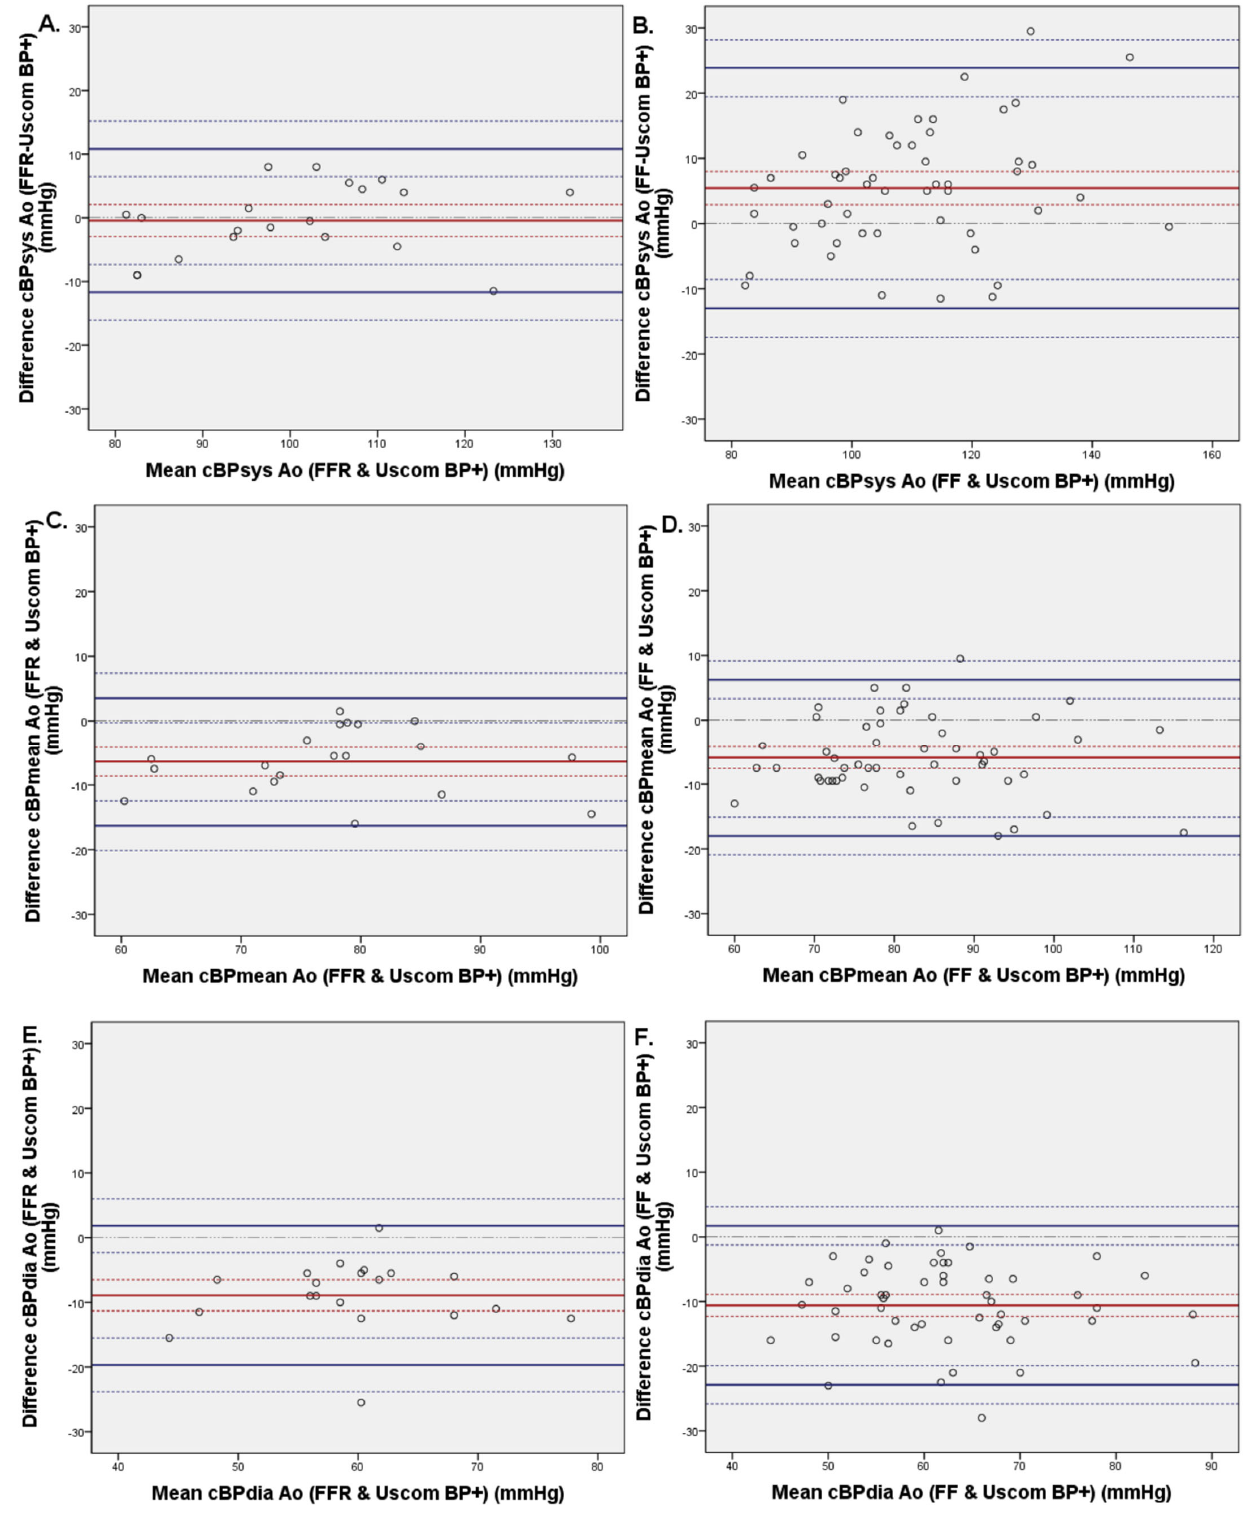
Figure 5. Bland–Altmann plots of systolic ( A , B ), mean ( C , D ), and diastolic ( E , F ) central blood pressure comparing non ‐ invasive blood pressure (Uscom BP+ device) with invasive central blood pressure measured with FFR wire on the left side ( n = 20) and with FF catheter on the right side ( n = 52).